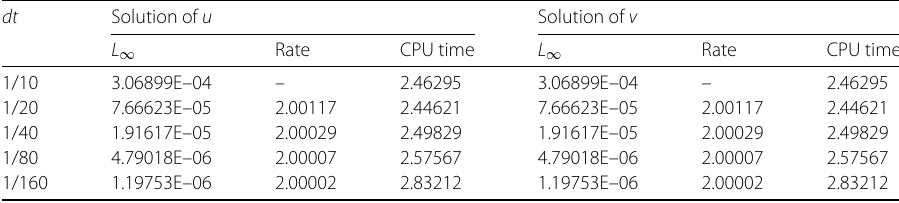
Table 12 Convergence rate of maximum error of Example 6 at T = 1 dt Solution of u Solution of v